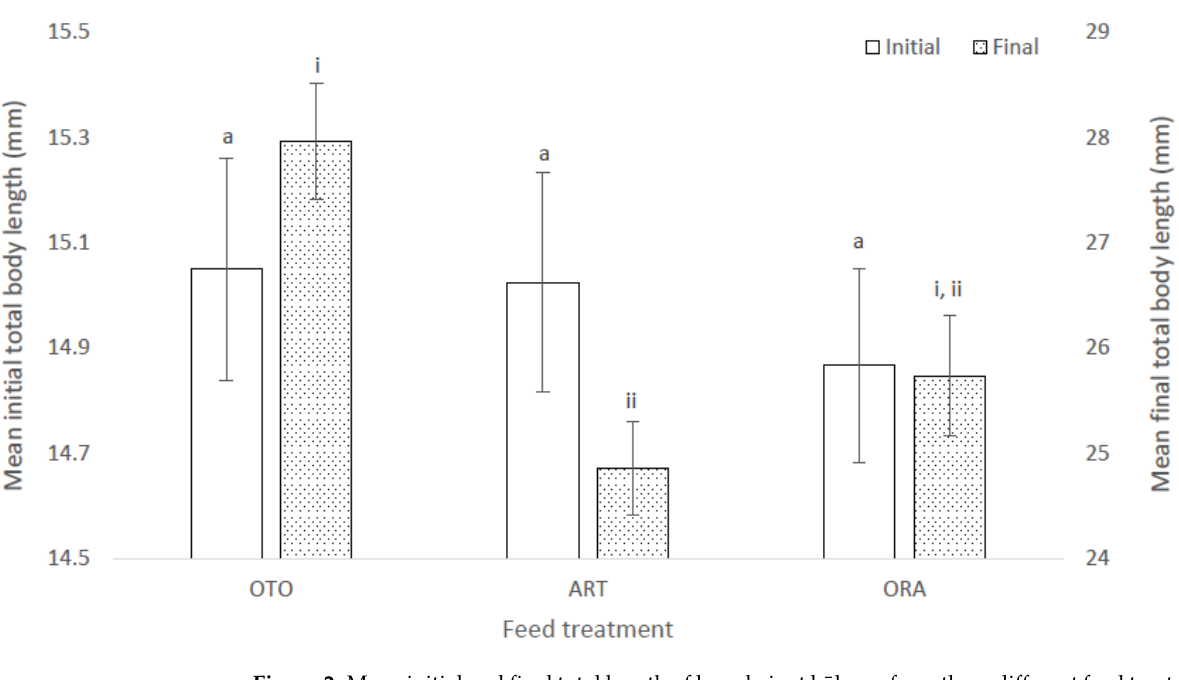
Figure 2. Mean initial and final total length of larval giant kōkopu from three different feed treatments; OTO (Otohime), ART (Artemac) and ORA (O.range) (mean ± SE). Means with different superscripts are significantly different among treatments for mean initial total length and among treatments for mean final total length ( p < 0.05).